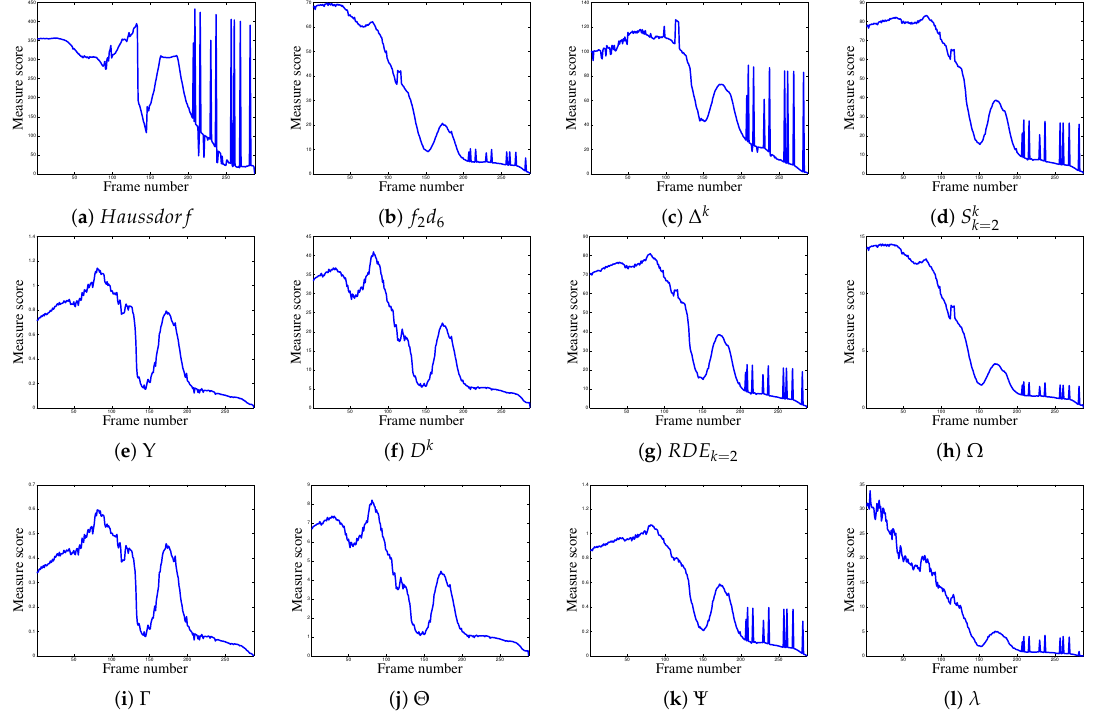
Figure A2. Behaviors of non-normalized localization metrics on real experiment with noisy images tied to video 3 (V3), with images of size 720 × 1280, see Figure